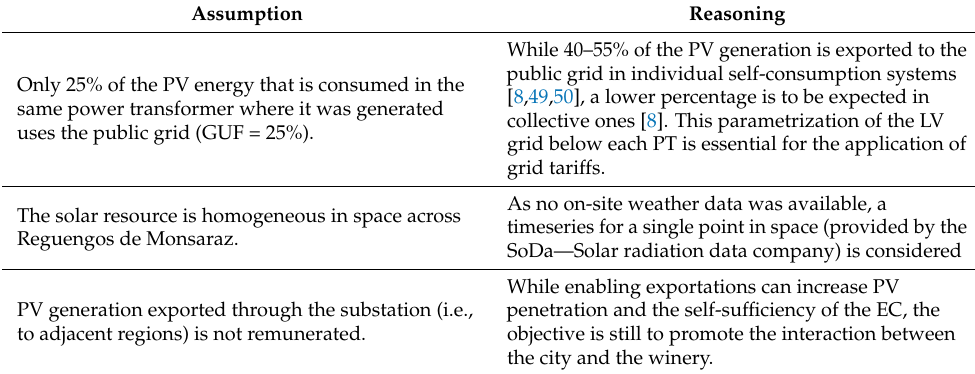
Table 3. Modeling assumptions considered in the present